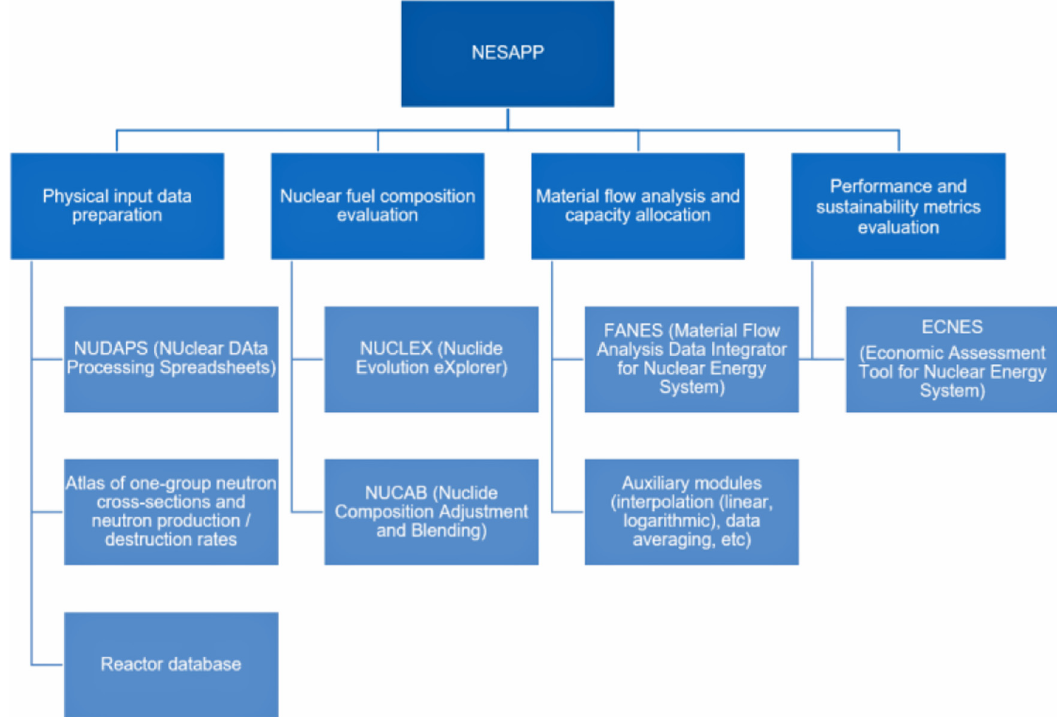
Fig. 3. Nuclear Energy System Modelling Application Package